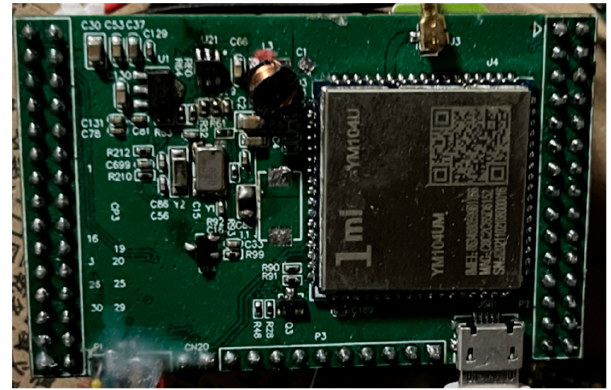
Figure 10. An LTE cat. 1 based RTU, used by EMULSION.